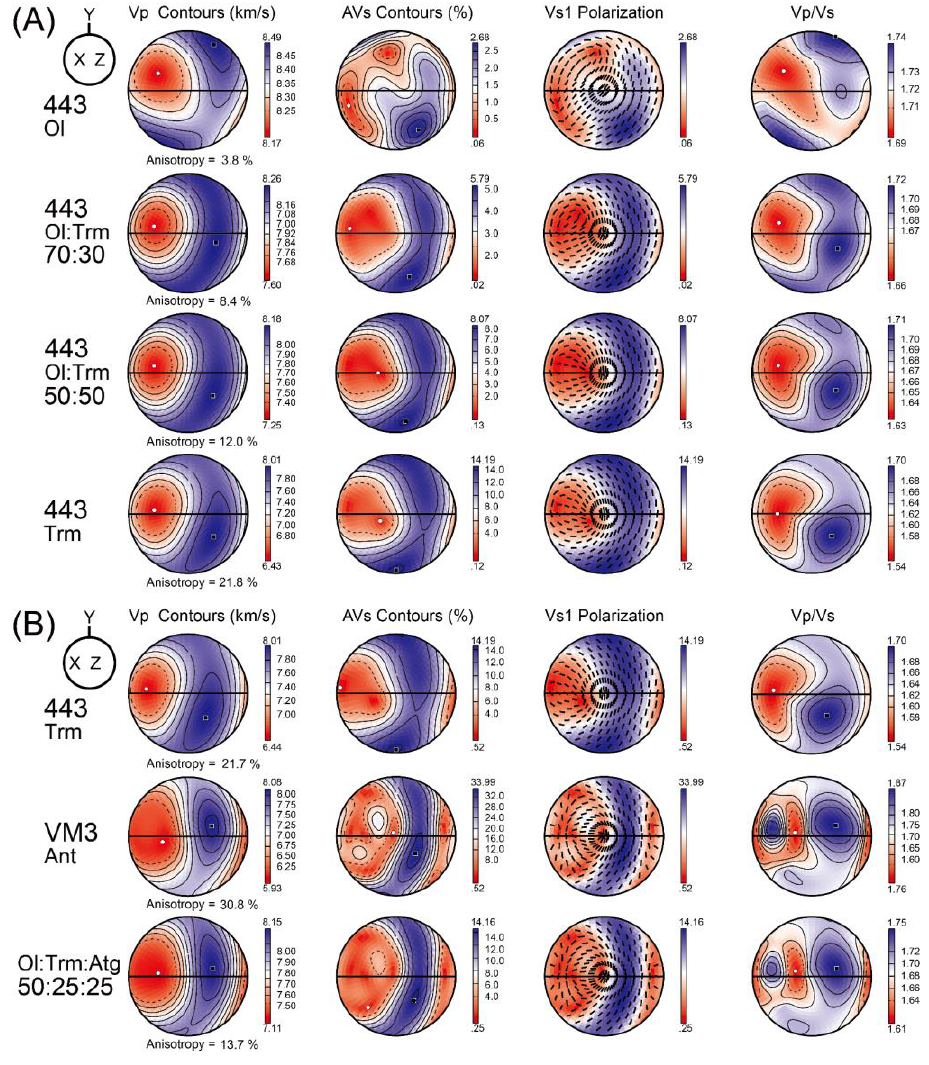
Figure 6. ( A ) Effect of amphibole on seismic velocity and anisotropy. LPO data of the olivine and tremolite in the tremolite-rich layer in sample 443 (Figure 4B) was used. ( B ) Effect of amphibole and serpentine on seismic velocity and anisotropy. LPO data of the olivine and tremolite in the tremolite-rich layer in sample 443 (Figure 4B) and LPO data of antigorite (VM3) reported by Jung [36] was used. The P-wave velocity (V P ), the amplitude of the shear-wave anisotropy (AV S ), the polarization direction of the faster shear wave (V S1 ), and the P- to S-wave velocity ratio (V P /V S ) are plotted in the lower hemisphere using an equal-area projection. The x direction and the z direction correspond to the lineation and the direction normal to the foliation, respectively. Ol: olivine, Trm: tremolite, Atg: antigorite.